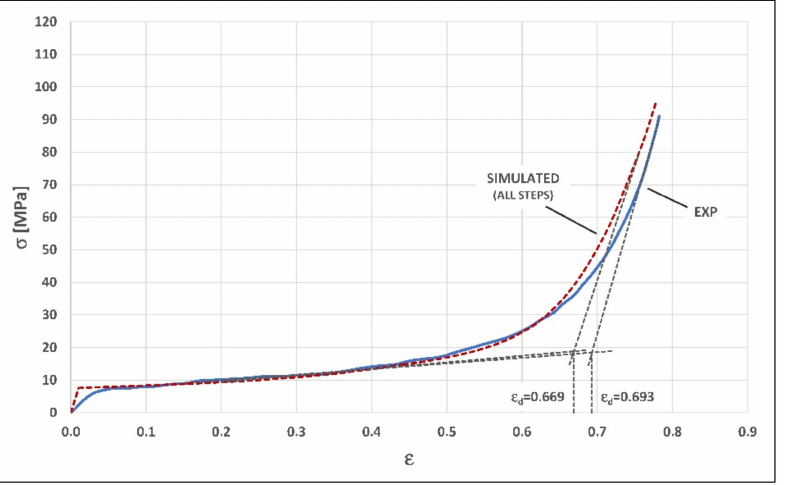
Figure 16. Comparison between experimental curve and predictive simulated curve (0.2% TiH 2